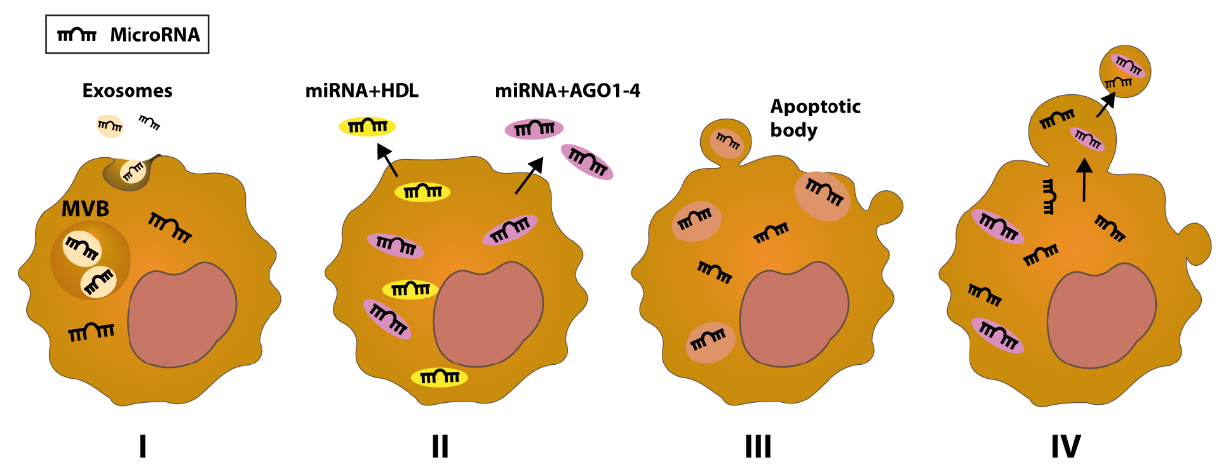
Figure 3. A simplified diagram of the formation processes and sources of circulating miRNAs. ( I ) MiRNAs are released from cancer cells within exosomes by the active mechanism of exocytosis. Multivesicular bodies (MVB) merge with the cellular membrane, releasing exosomes. ( II ) Vesicle-free miRNAs represent most of the circulating microRNAs. The association between miRNAs and RNA-binding proteins such as AGO 1–4 maintains the stability of associated miRNAs against nuclease and protease. The complex can be either released into the extracellular space or can be loaded into shedding vesicles. MiRNA can also be attached to high-density lipoproteins (HDL). ( III ) MiRNA can be released via apoptotic bodies containing diversified cellular organelles including miRNAs. ( IV ) MiRNA can be delivered into circulation, as they are enclosed with a cellular membrane forming a shedding vesicle (SV).